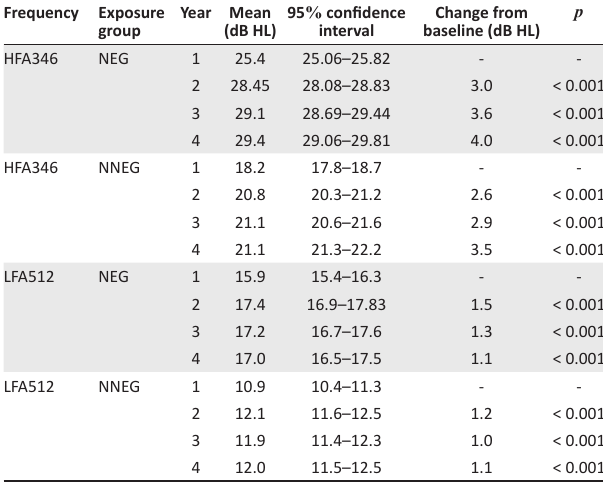
TABLE 3: Mixed-effects regression analysis of average hearing over the first four serial (yearly) audiograms for the non-noise exposed group and noise exposed group, unadjusted for age. Frequency Exposure